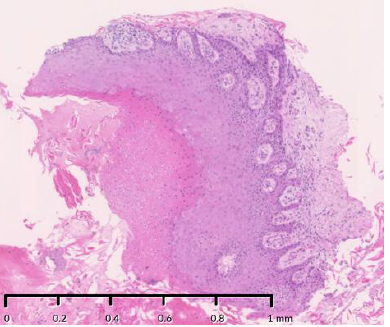
Figure 3. Panorama X-P. The osteolytic lesion of the left mandible was significantly enlarged.